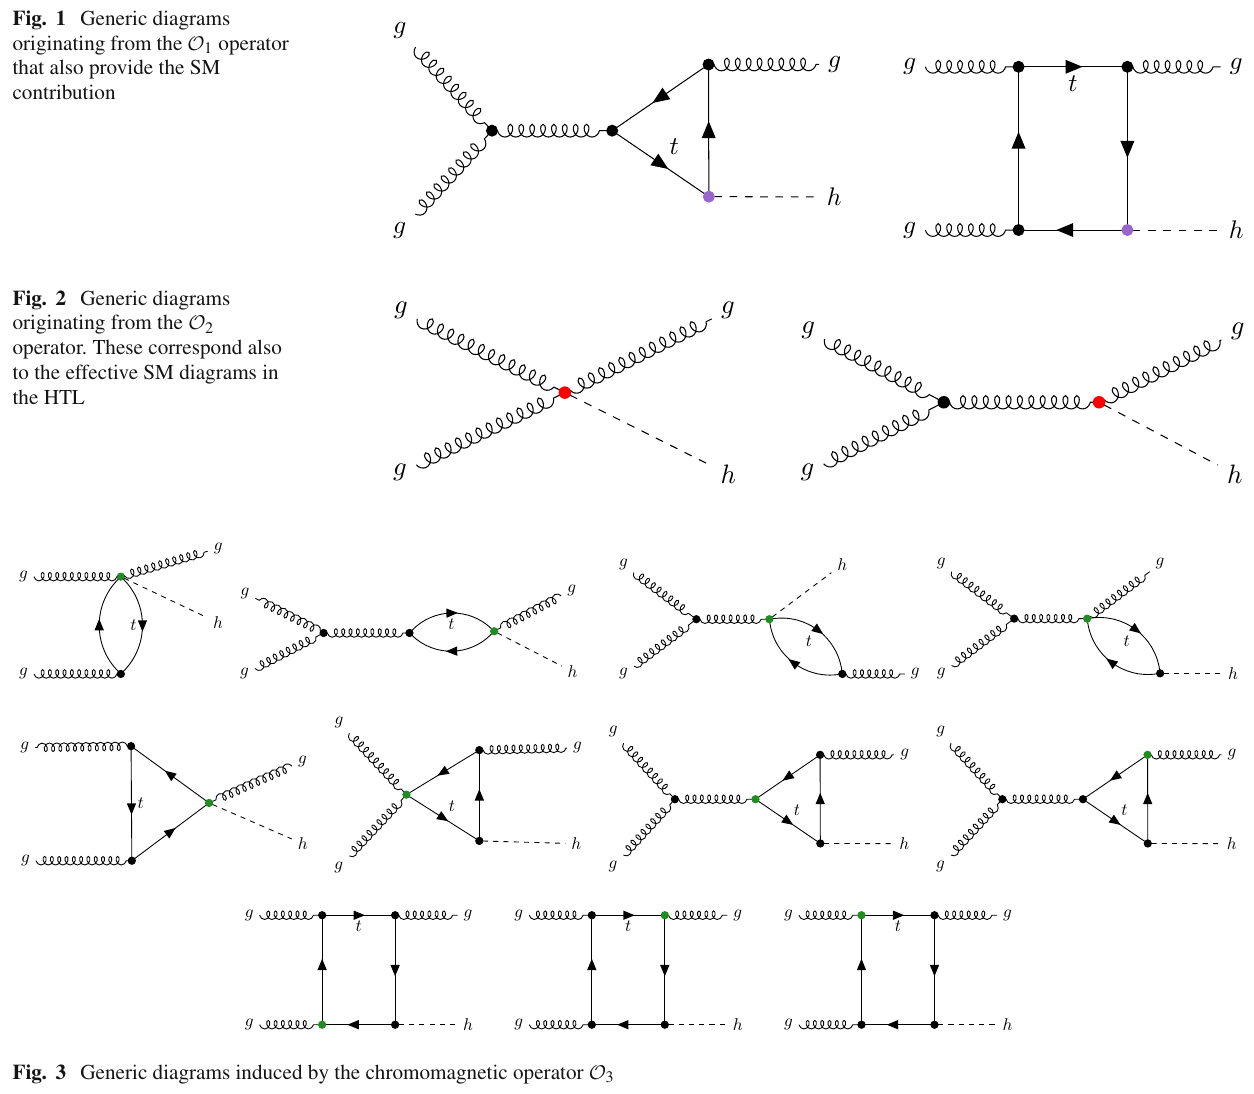
Fig. 3 Generic diagrams induced by the chromomagnetic operator O 3 The contributing generic SM diagrams are shown in Fig.